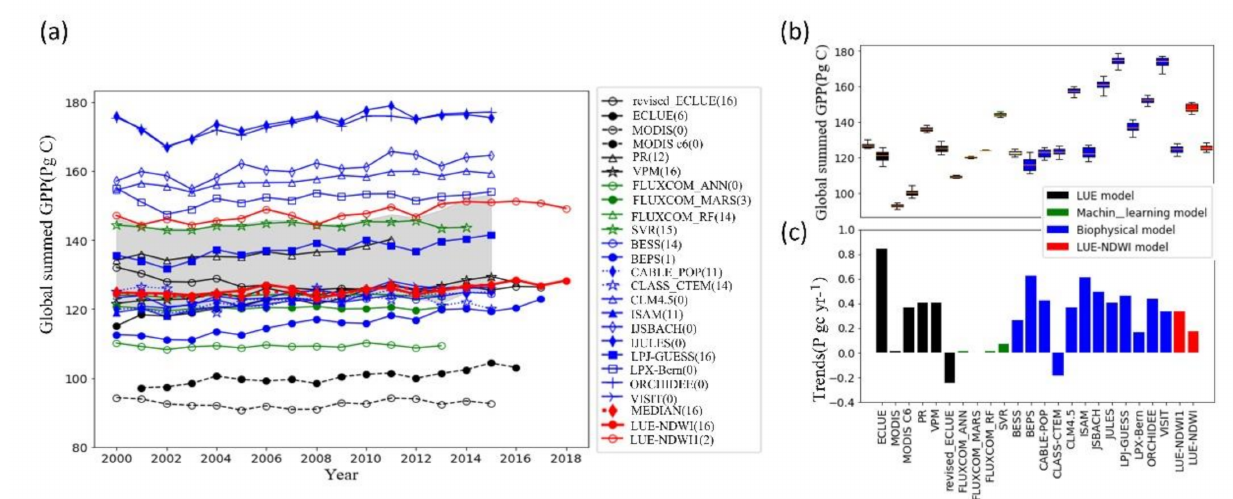
Figure 5. ( a ) Comparison of annual global GPP estimates from various models. The number after each model’s name in parentheses is the model’s number of years in the interquartile range (IQR) of all global GPP products, indicated by the shaded region. LUE-NDWI (data corrected) and LUE-NDWI1(i.e., LUE-NDWI with spatial data uncorrected) are GPP estimated by LUE-NDWI with corrected and uncorrected input data, respectively. ( b ) Boxplot of annual GPP values during the study period for each model. ( c ) Trends of annual GPP (Pg C yr − 1 ) by model. Symbols of LUE models are in black, machine learning models in green, and biophysical models in